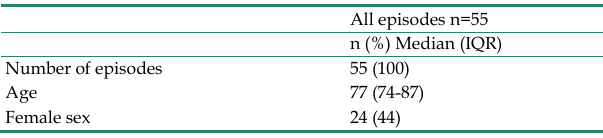
Table 1 . Clinical and microbiological features of patients with enterococcal